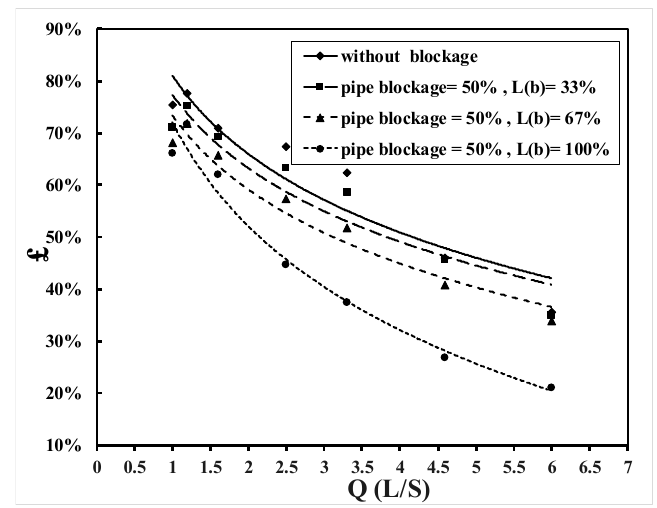
Figure 16. Relationship between £ and Q for different LB with HB 25%.